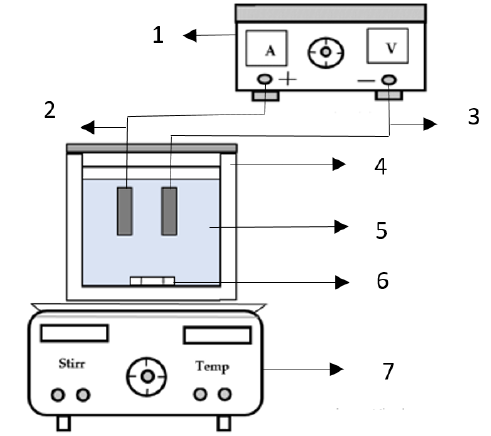
Figure 1. Schematic diagram of electrocoagulation (EC) reactor: (1) DC power supply, (2) anode, (3) cathode, (4) reactor, (5) cold meat industry wastewater (6) magnetic stir bar and (7) magnetic stirrer.